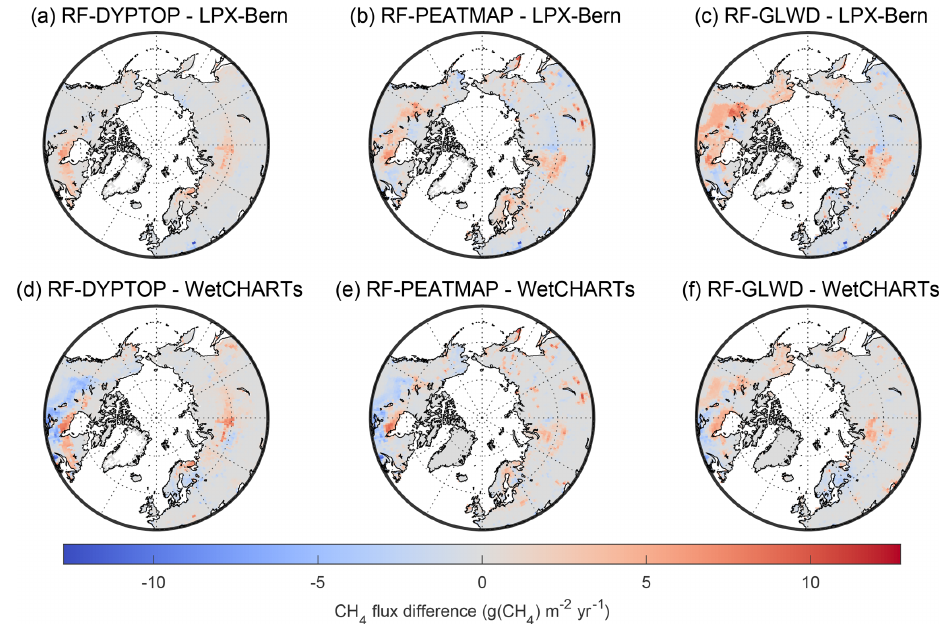
Figure 7. Difference in mean annual CH 4 wetland emissions during the years 2013–2014 estimated by upscaling EC data using the RF model with different wetland maps and process models. All the CH 4 emission maps were aggregated to 1 ◦ resolution before comparison. The flux rates refer to total unit area in a grid